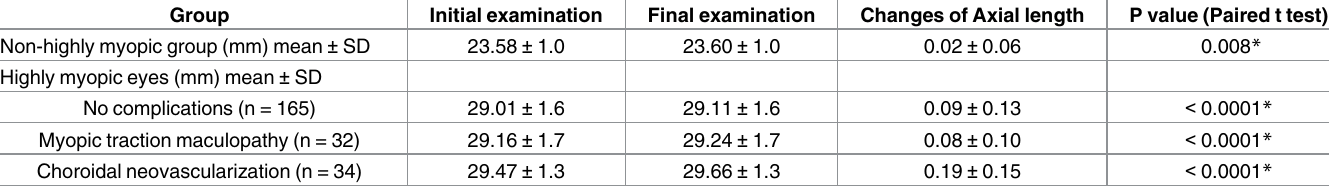
Table 4. Comparison of axial length (mm) between at the initial examination and at the final examination in each group. Group